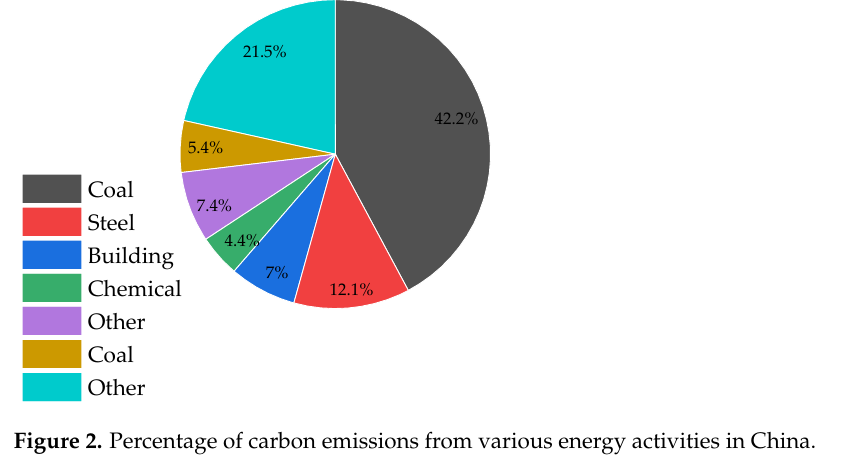
Figure 2. Percentage of carbon emissions from various energy activities in China. Based on their resource endowment and strategic layout, more coal enterprises in China have formed a more mature coal-power industry chain and coal-chemical industry chain. The coal-electricity industry chain mainly uses less coalified bituminous coal and brown coal for the burning of power. Using the heat generated by burning coal, the thermal energy is converted into electrical energy that can be more easily stored and used. In the coal-chemical industry chain, the modern coal chemical industry, as an alternative supplement to petroleum products, has a large one-time construction investment, a long capital recovery period, and therefore high depreciation and amortization costs. The chemical products are mainly converted from coal, and the raw materials and power fuels mainly come from coal. There is high coal consumption per unit of chemical products, and high resource consumption. There is also high volatility of coal market price and